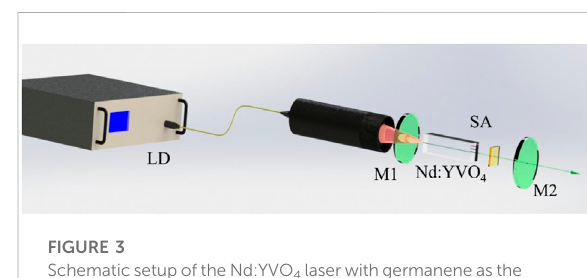
FIGURE 3 SchematicsetupoftheNd:YVO 4 laserwithgermanene asthe saturable absorber. LD: laser diode; SA: Ge-N saturable